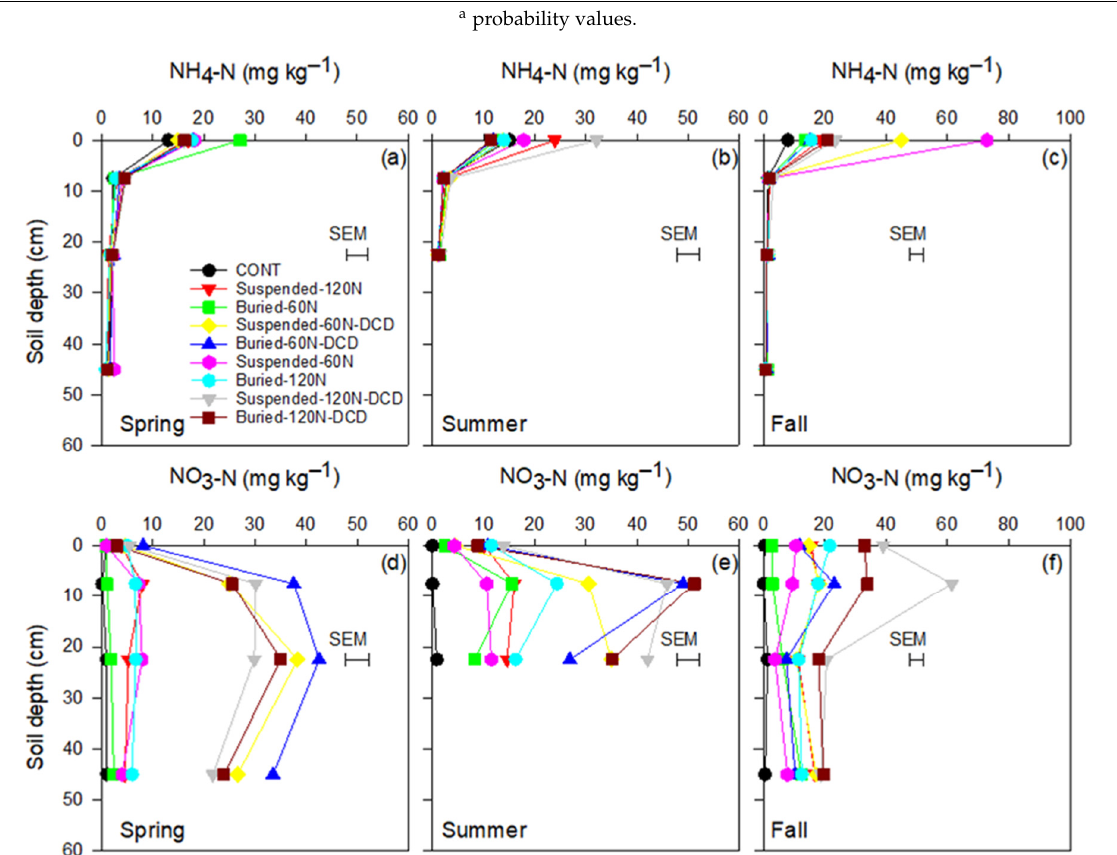
Figure 2. Concentrations of ( a – c ) ammonium nitrogen (NH 4+ -N, mg kg –1 ) and ( d – f ) nitrate nitrogen (NO 3 − -N, mg kg –1 ) at 0–15 cm, 15–30 cm, 30–60 cm and sawdust mulch layer (0 cm; 8 cm of sawdust) with annual applications of combination of nitrogen fertilizer rates and nitrification inhibitors (2-chloro-6-(trichloromethyl)-pyridine (Nitra-pyrin), di-cycandiamide (DCD)) in soils collected in a long-term blueberry experiment during the growing season (spring, summer, fall) in 2016 (N = 396).